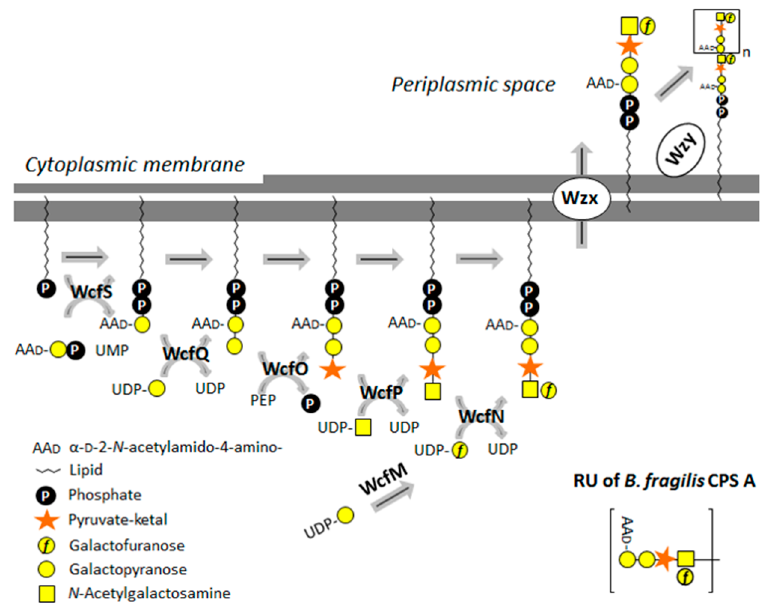
Scheme of capsular polysaccharide (CPS) A biosynthesis in Bacteroides fragilis . The pyruvylation step occurs in the cytoplasm at the stage of the lipid-PP-linked RU precursor. Pyruvylation (WcfO) is indicated by a star. Notably, in contrast to succinoglycan biosynthesis (Figure 2), pyruvylation of the internal Gal p of the RU needs to proceed prior to completion of the lipid-PP-linked tetrasaccharide repeat. RU: repeating unit. Monosaccharide symbols are shown according to the Symbol Nomenclature for Glycans (SNFG) [45].